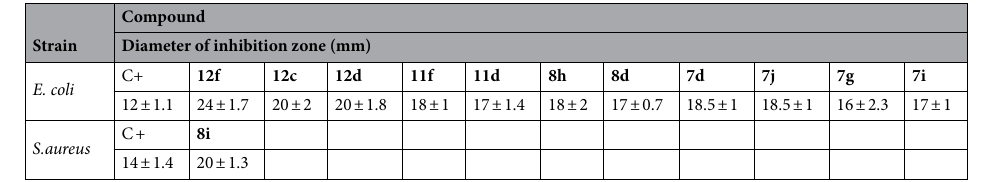
Table 5. The antibacterial activity for assay for the most active hybrid quinoline–imidazole/benzimidazole compounds ( 12f , 12c , 12d , 11f , 11d , 8h , 8d, 7d , 7j , 7g , 7i and 8i ), determined by disk diffusion assay. E. coli Escherichia coli ATCC 25922, S. aureus Staphylococcus. aureus ATCC 25923, X ± SD mean of three mesearurements ± standard deviation. C+ Gentamicin for S. aureus and E.